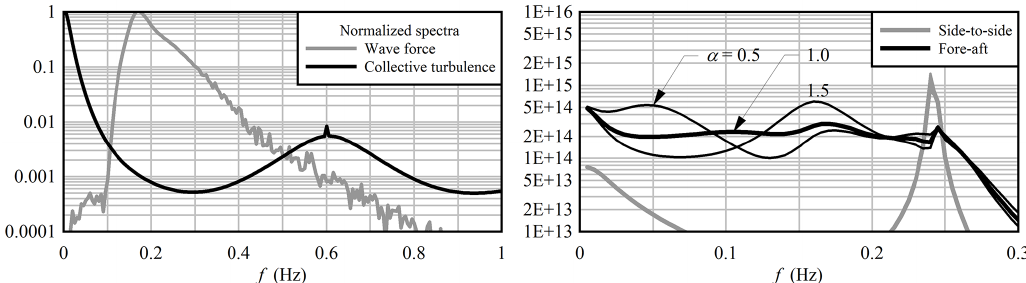
Figure 4. On the left: normalized spectra of the collective component of rotationally sampled axial turbulence ( V ∞ = 16ms − 1 , I = 0.15) at r / R = 0.75 and ocean wave loads with H s = 2m and T p = 6s. On the right: spectra of tower bending moments at the mud line, for gain multiples of 0.5, 1.0 (thick line), and 1.5. (The three curves associated with the side-to-side spectra